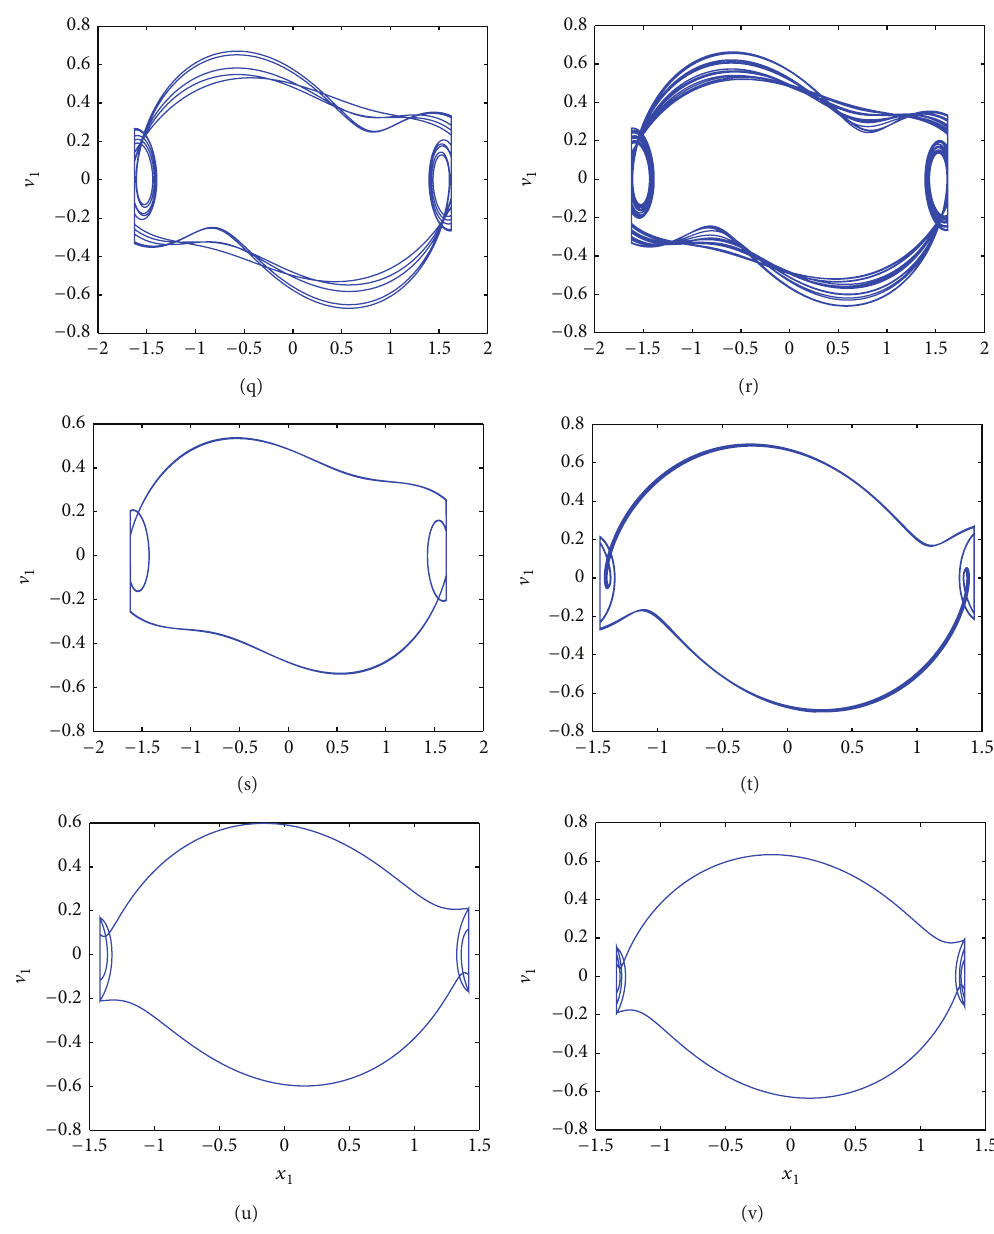
Figure 9: Phase diagrams ((a)–(k)) of periodic motions ( 𝜔 = 0.29 ) and phase diagrams ((l)–(v)) of periodic motions ( 𝜔 = 0.27 ).